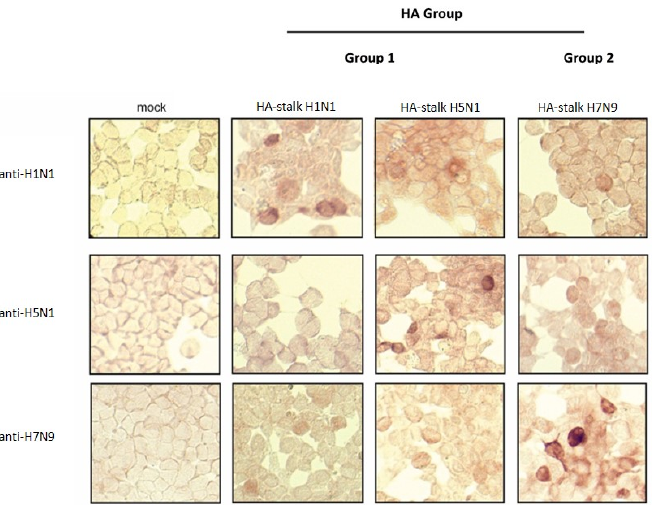
Figure 8. Expression of HA-stalk antigens from the 1 and 2 HA groups in mammalian cells. HEK293 cells were transfected with HA-stalk H1N1, H5N1 and H7N9 constructs. Protein expression was detected using different monoclonal antibodies specific for H1N1, H5N1 and H7N9 influenza strains. Non-transfected cells were used as a negative control. Images were taken at ×40 magnification.